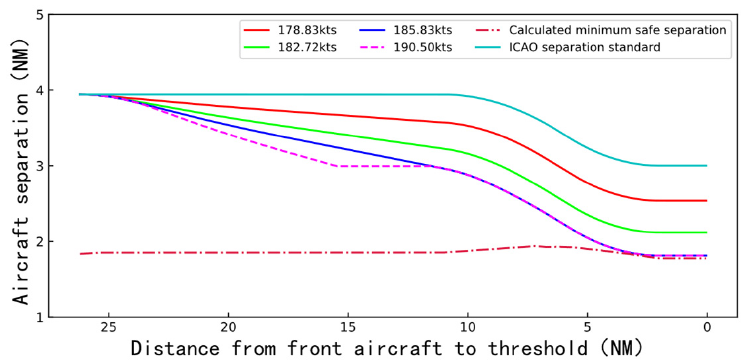
Figure 7. Dynamic separation change when CRJ-900 follows a medium aircraft.